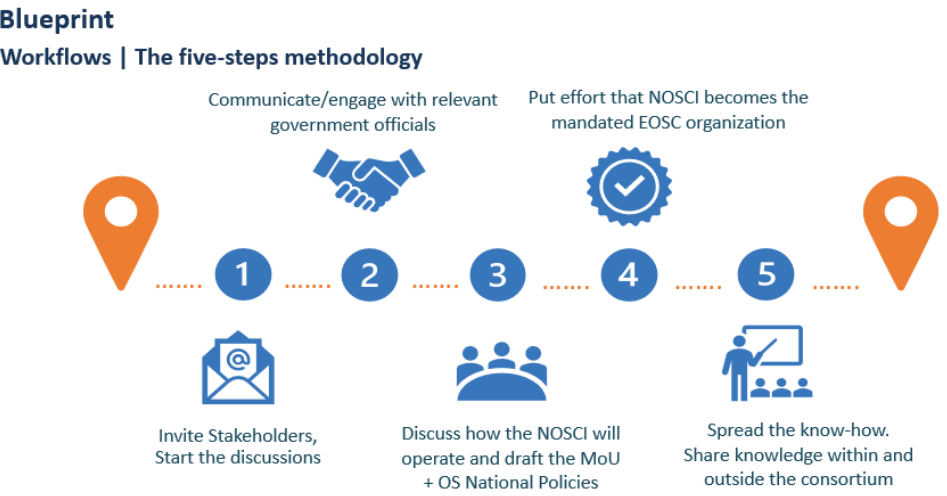
Figure 4. A blueprint of the five-step set-up methodology for the NOSCIs.